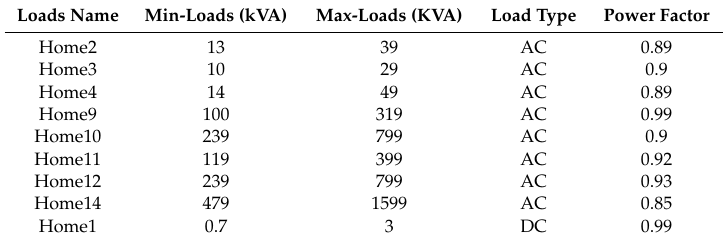
Table 2. Microgrid load data.